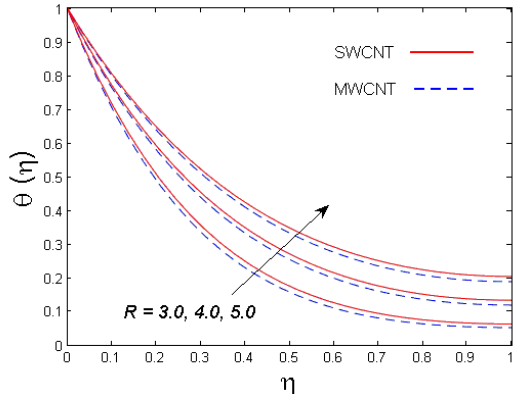
Figure 11. The illustration of R versus θ(η).